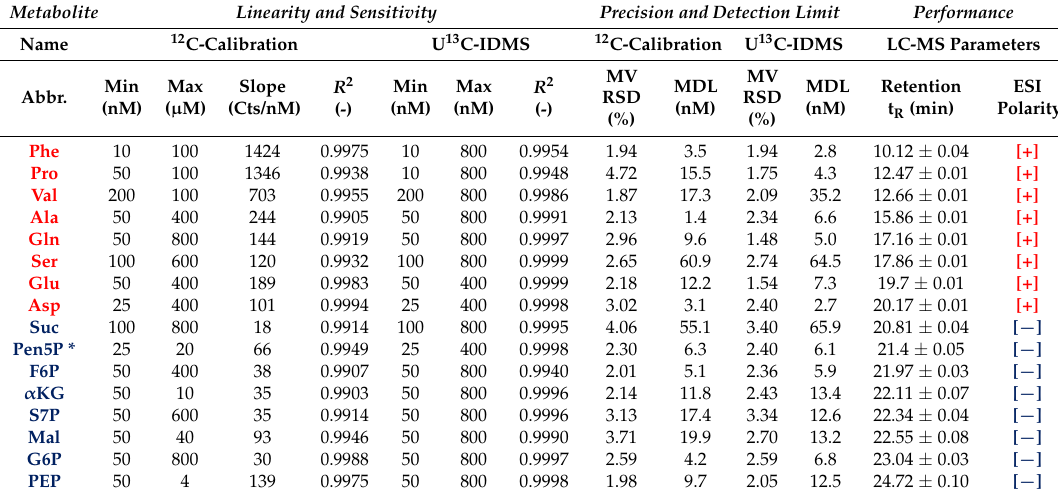
Table 1. Quantification parameters of targeted metabolites by standard-based external 12 C and IDMS U 13 C calibration using QQQ-MRM detection in positive (red) and negative (blue) ionization mode (5 µ L sample injection). See Tables S1–S4 for the full names of abbreviated metabolites. Metabolite Linearity and Sensitivity Precision and Detection Limit